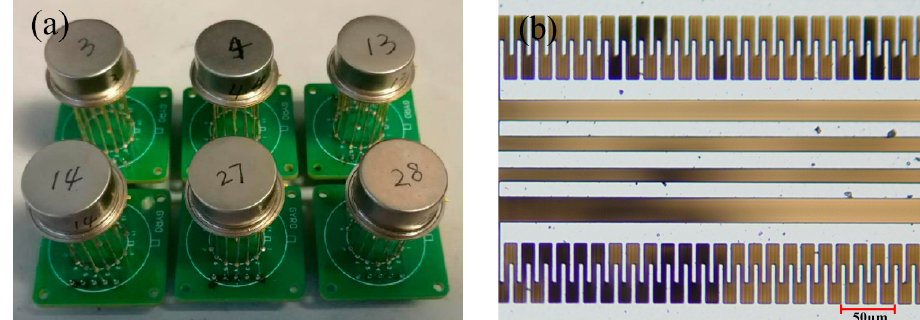
Figure 1. Schematic illustration of ( a ) test sample and ( b ) internal structure diagram.